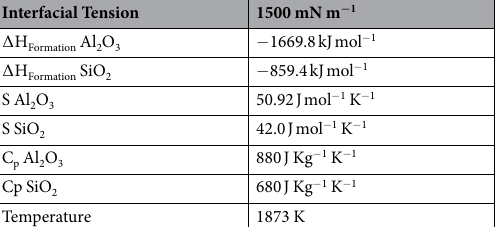
Table 3. The literature values used for calculation of global interfacial tension and dissipation of free energy as displayed in Fig. 11.